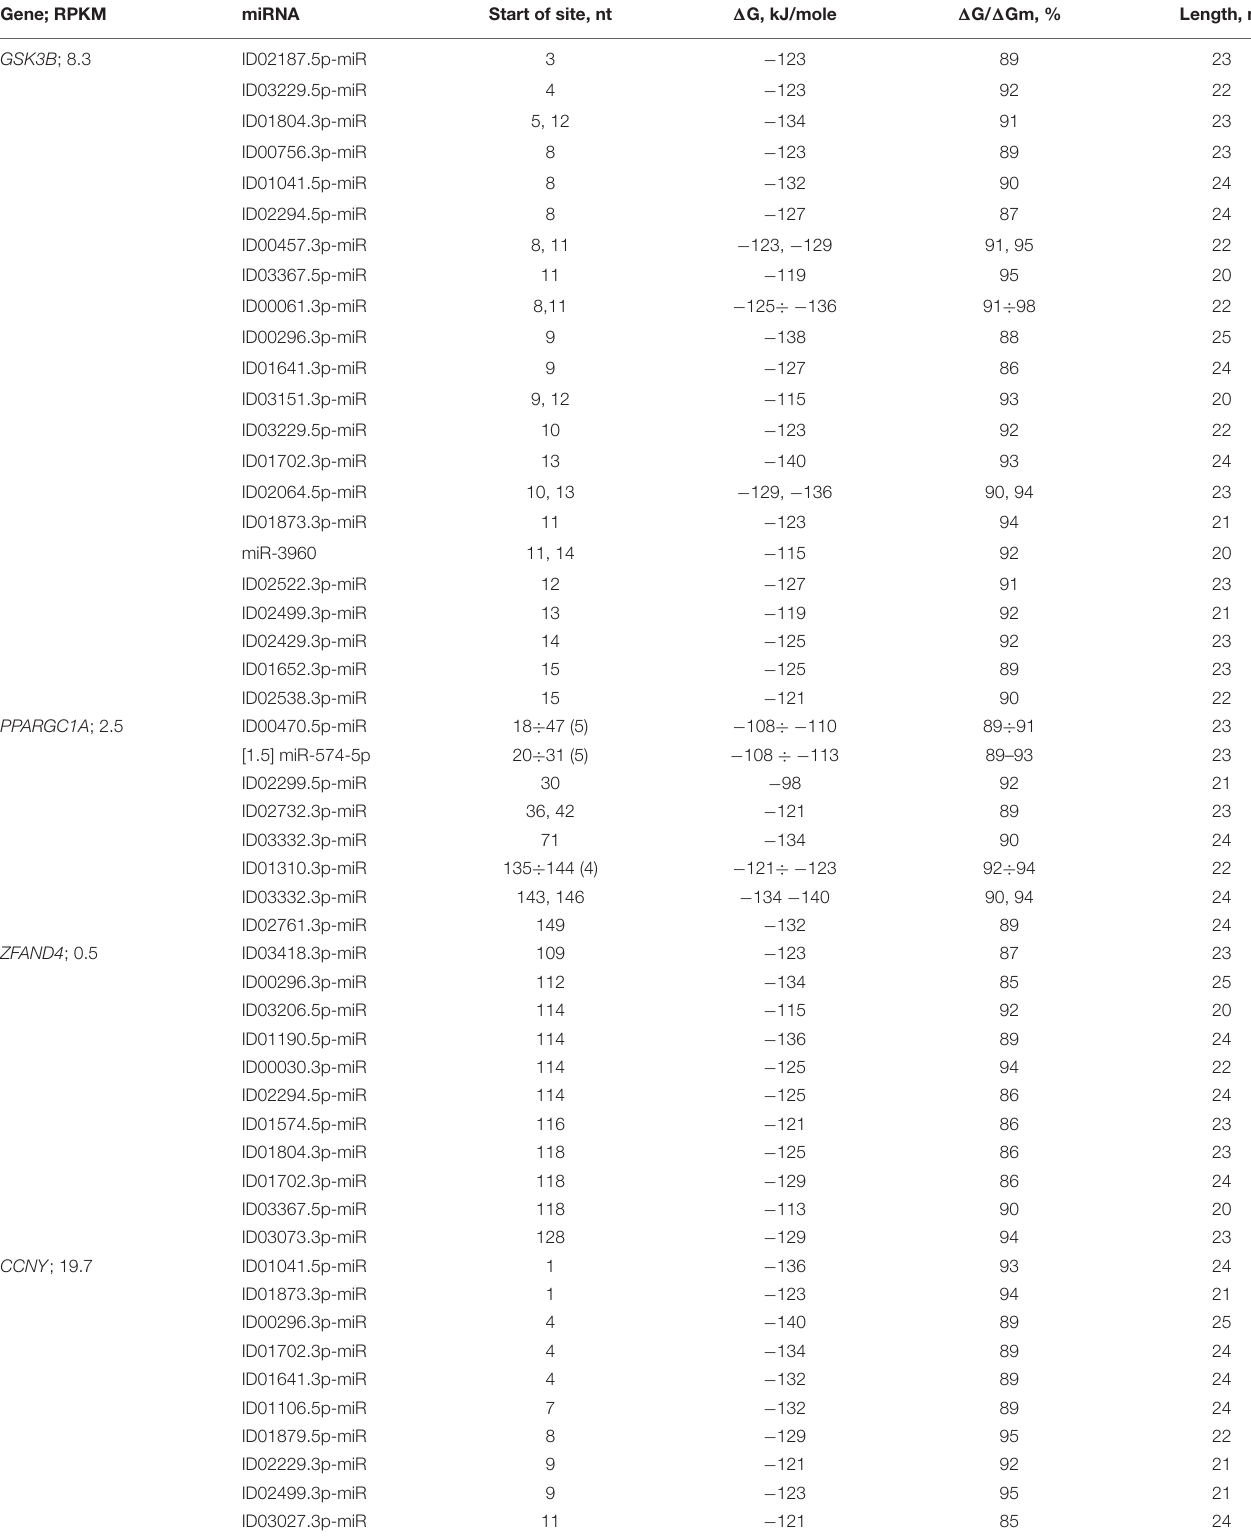
TABLE 1 | Characteristics of miRNA interactions with 5 (cid:48) UTR mRNAs of candidate PD genes. Gene; RPKM miRNA Start of site, nt (cid:49) G, kJ/mole (cid:49) G/ (cid:49) Gm, % Length, nt GSK3B ;